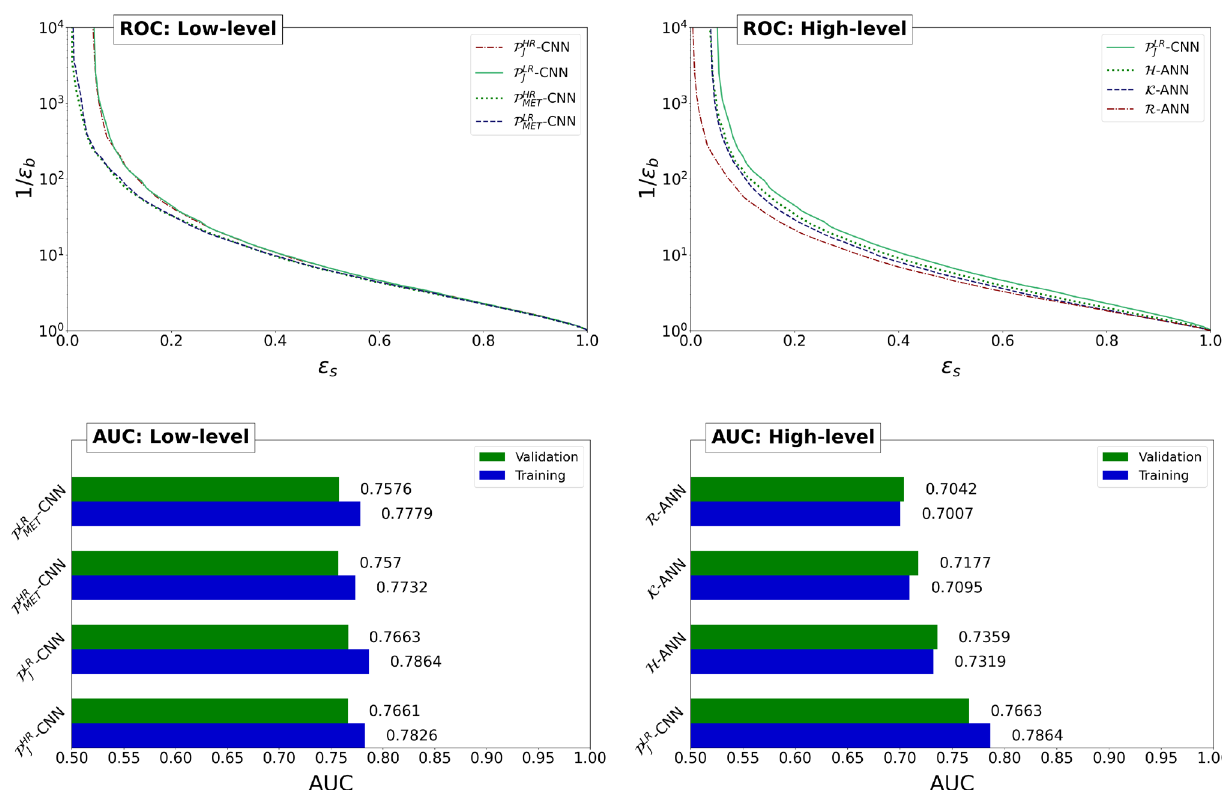
ing CNN is added to the plots on the right. The x-axis of the ROC-curve isthesignalacceptance (cid:10)